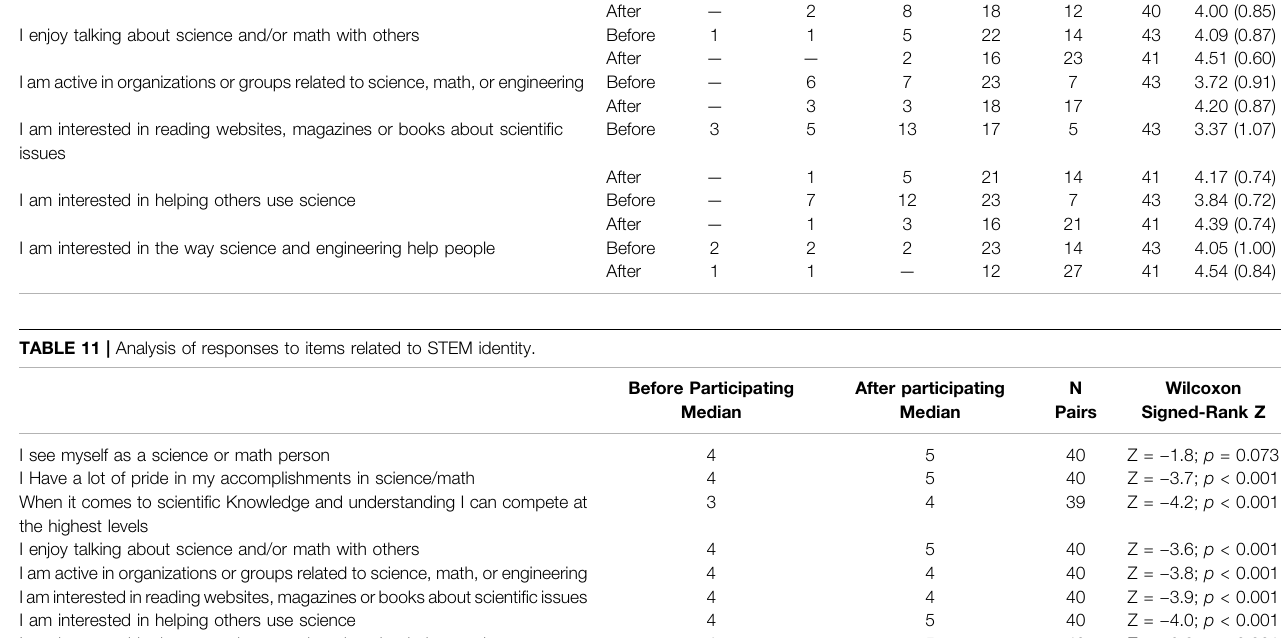
Disagree Disagree